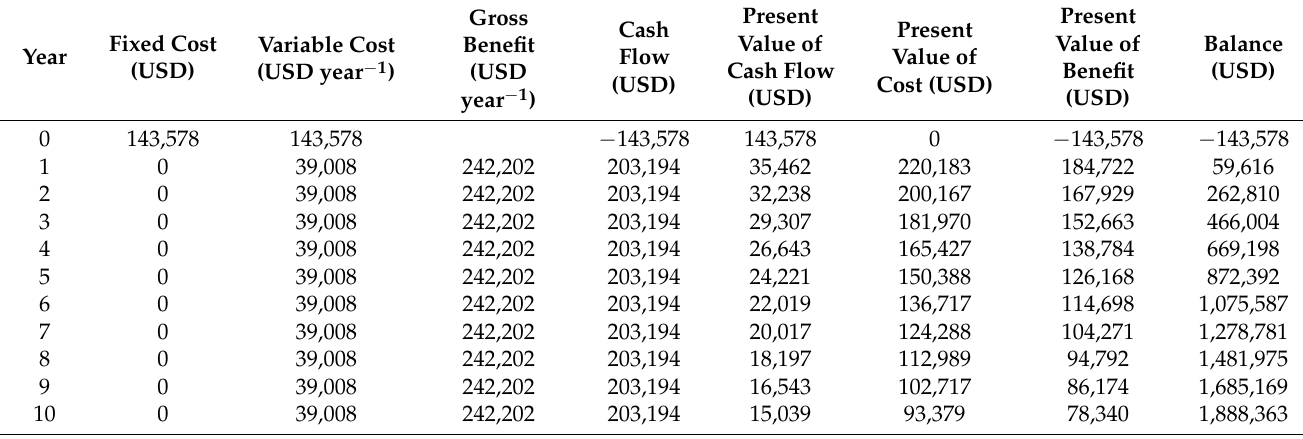
Table 8. NPV, BCR, IRR, and PP calculation for large combine at DF